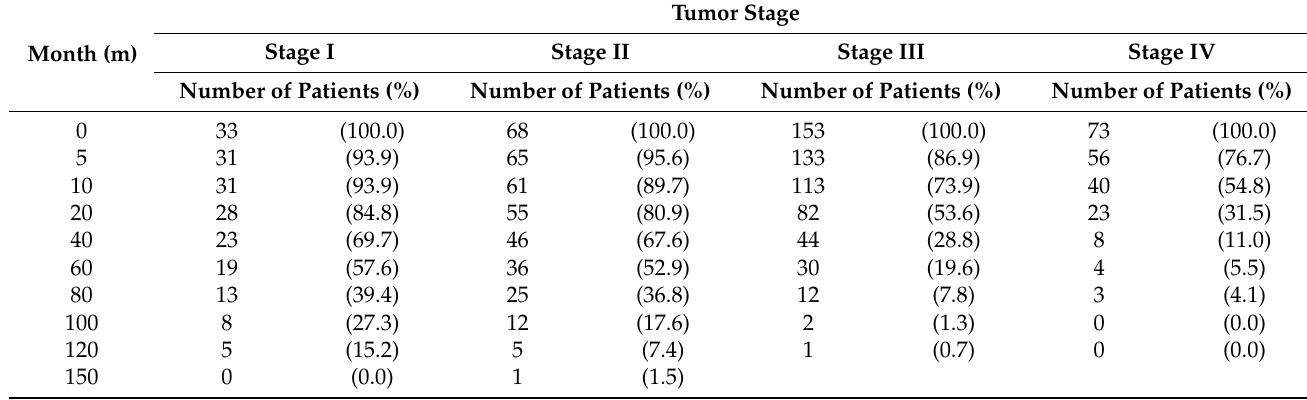
Table 3. Overall survival of gastric cancer patients with high HSF1 expression according to the diseases stage (HSF1 probe: Affy ID: 213756_s_at